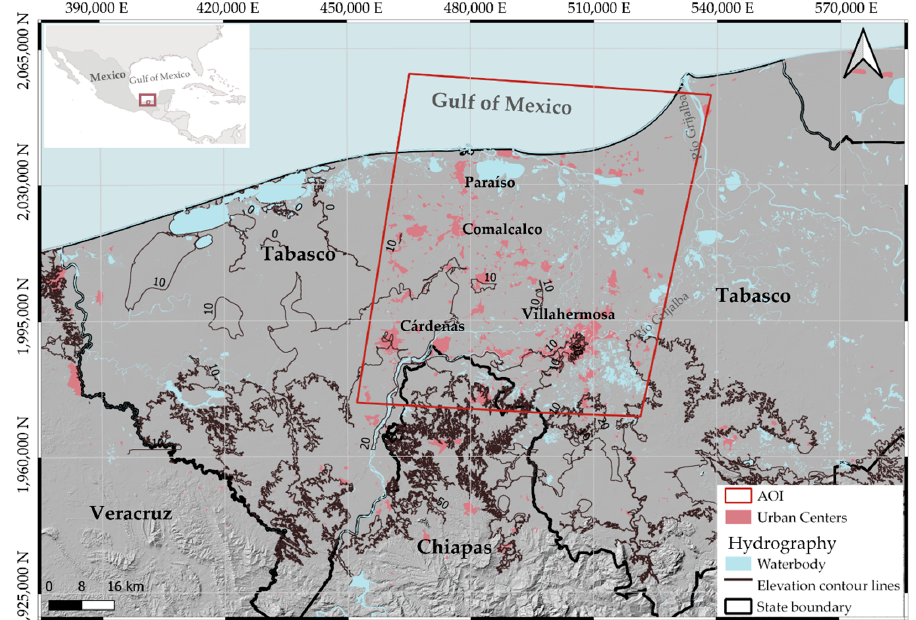
Figure 1. Central region of Tabasco (AOI) and its main urban areas, hydrography, and topography. The background image is a shaded relief based on the INEGI elevation model (www.inegi.org.mx, accessed on 11 July 2022).